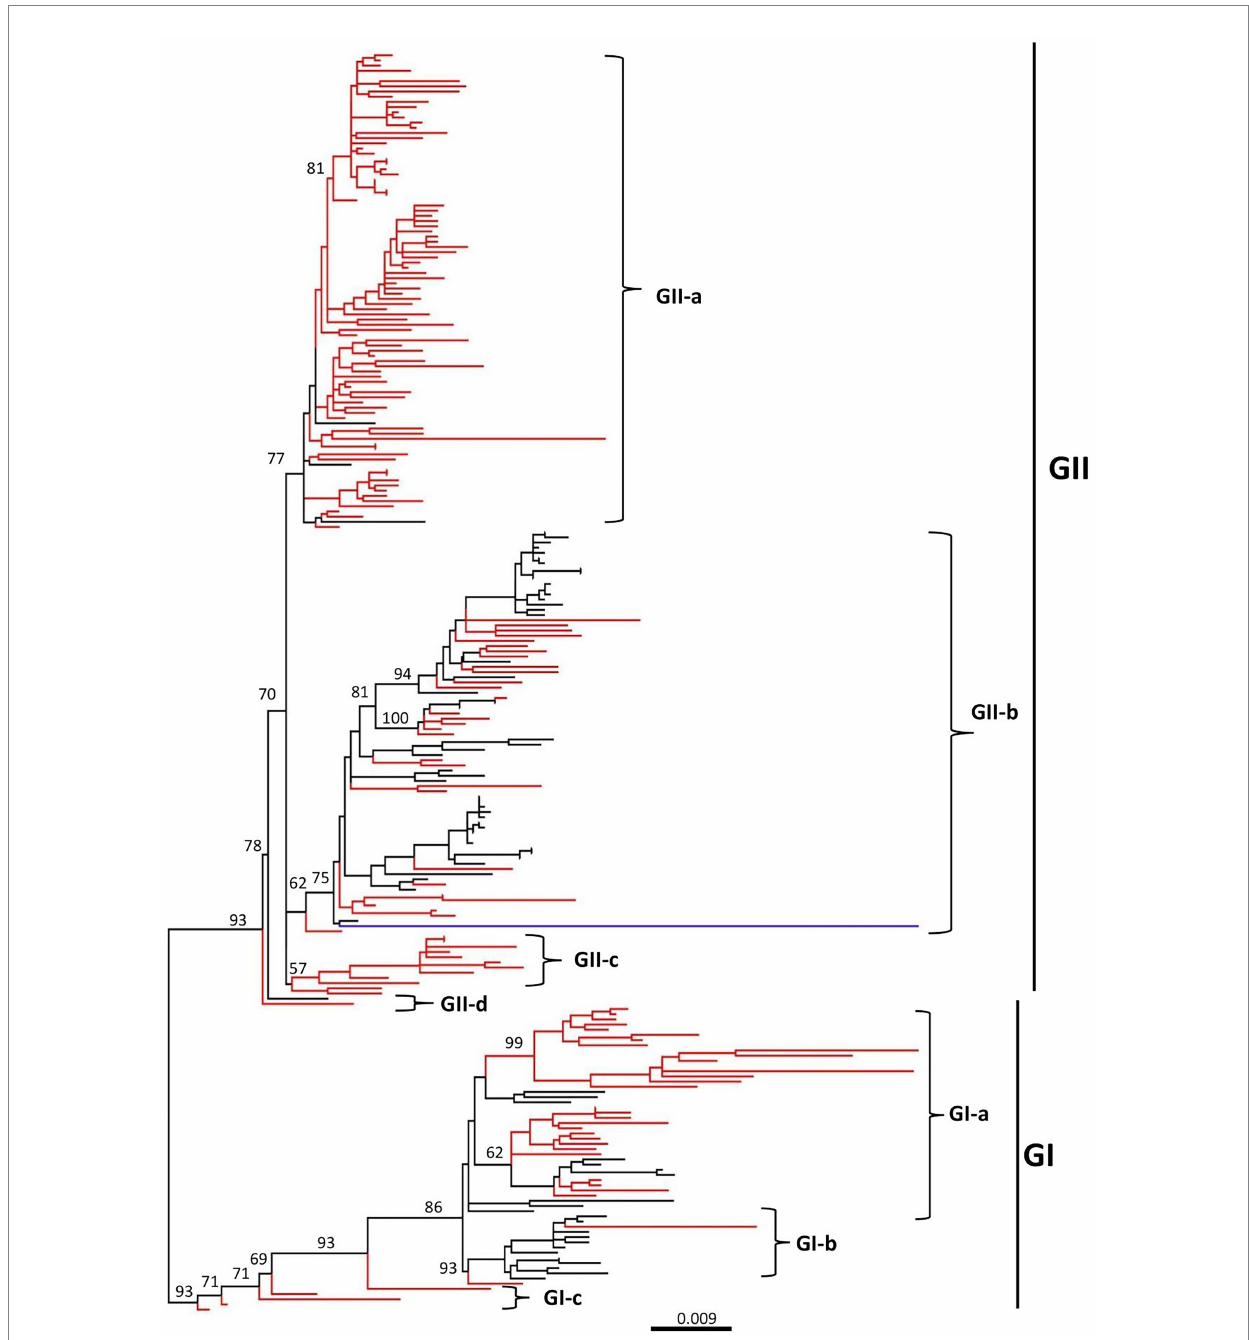
FIGURE 1 Phylogenetic tree based on the full-length genome sequences of CAV strains, 1991–2020. ML (maximum likelihood) phylogenetic tree of 243 full- length genome sequences of CAV classified all strains into two major clades, GI and GII. GI can be further classified into three sub-clades (GI-a, GI-b, and GI-c), while GII into four sub-clades (GII-a, GII-b, GII-c, and GII-d). The major clades and sub-clades of the CAV are indicated. The percentage of replicate trees in which the associated taxa clustered together in the bootstrap test (1,000 replicates) are indicated at each node. The evolutionary distances were computed using the best-fit substitution model TIM3+F+I+G4. The tree was visualized and modified to be proportional using FigTree v1.4. The branches in red color represents the CAVs isolated in China, while the blue color branch represents the CAV vaccine strain (GenBank ID: EF683159.1). The detailed information about the viruses in the tree can be seen in Supplementary Figure